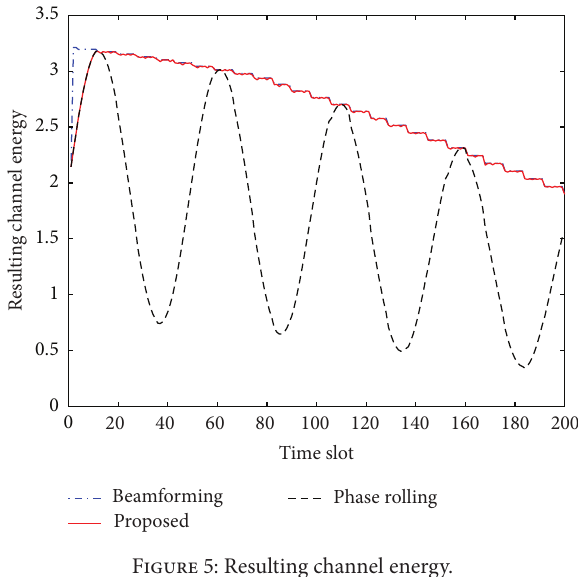
Figure 7: Data rates with the modified PF scheduling algorithm.